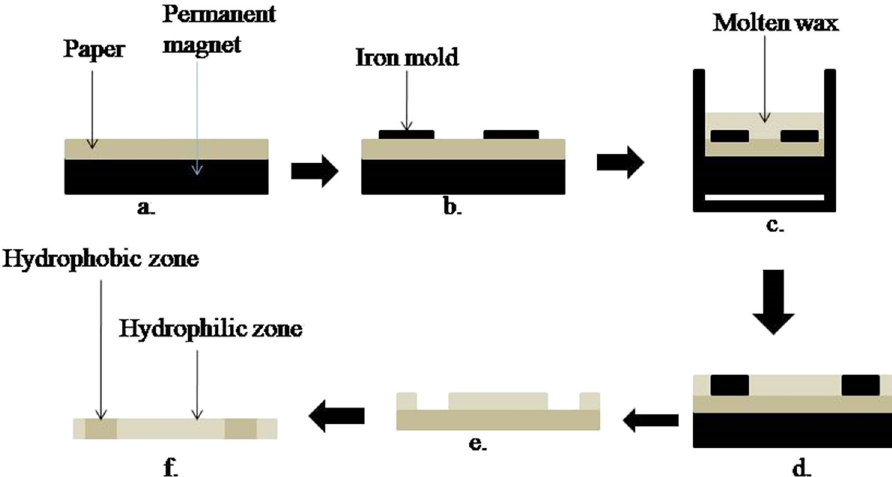
Figure 6: Setup for wax dipping fabrication of PADs: ( a ) paper setup on magnet, ( b ) iron moulds placed over paper, ( c ) setup placed in molten wax, ( d ) setup removed from wax coating formed, ( e ) moulds removed from paper and paper is heated, and ( f ) permeation of wax into micro - porous channels of paper forming distinct hydrophobic and hydrophilic